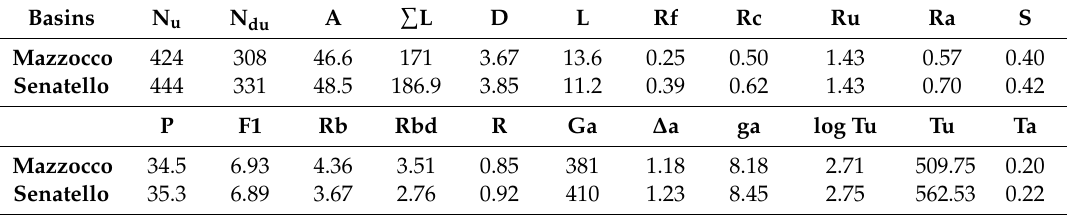
Table 4. Geomorphic quantitative parameters in Mazzocco and Senatello river basins. Basins N u N